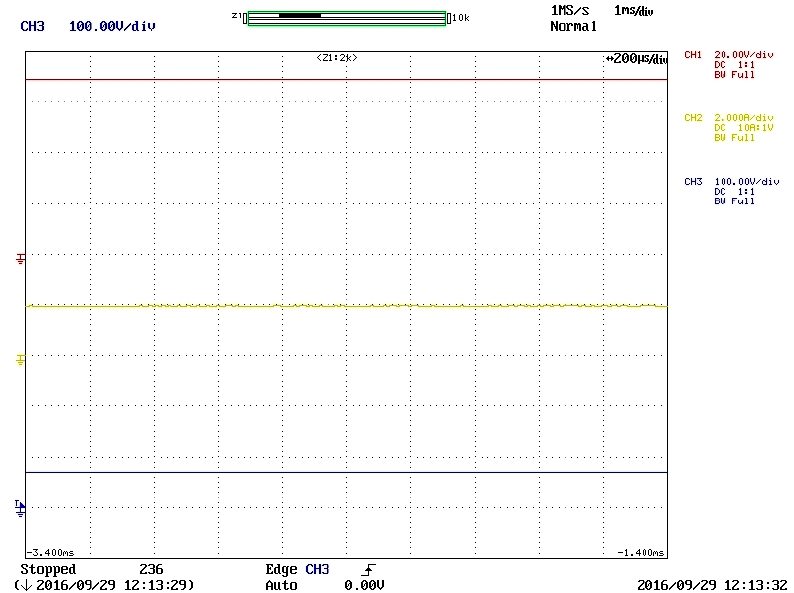
Figure 25. Results for partial shading condition obtained by hardware implementation: CH1 : voltage across the load resistance (67 V); CH2 : current across the load (1.9 A); and CH3 : solar PV array’s terminal voltage ( V PV = 70 V).